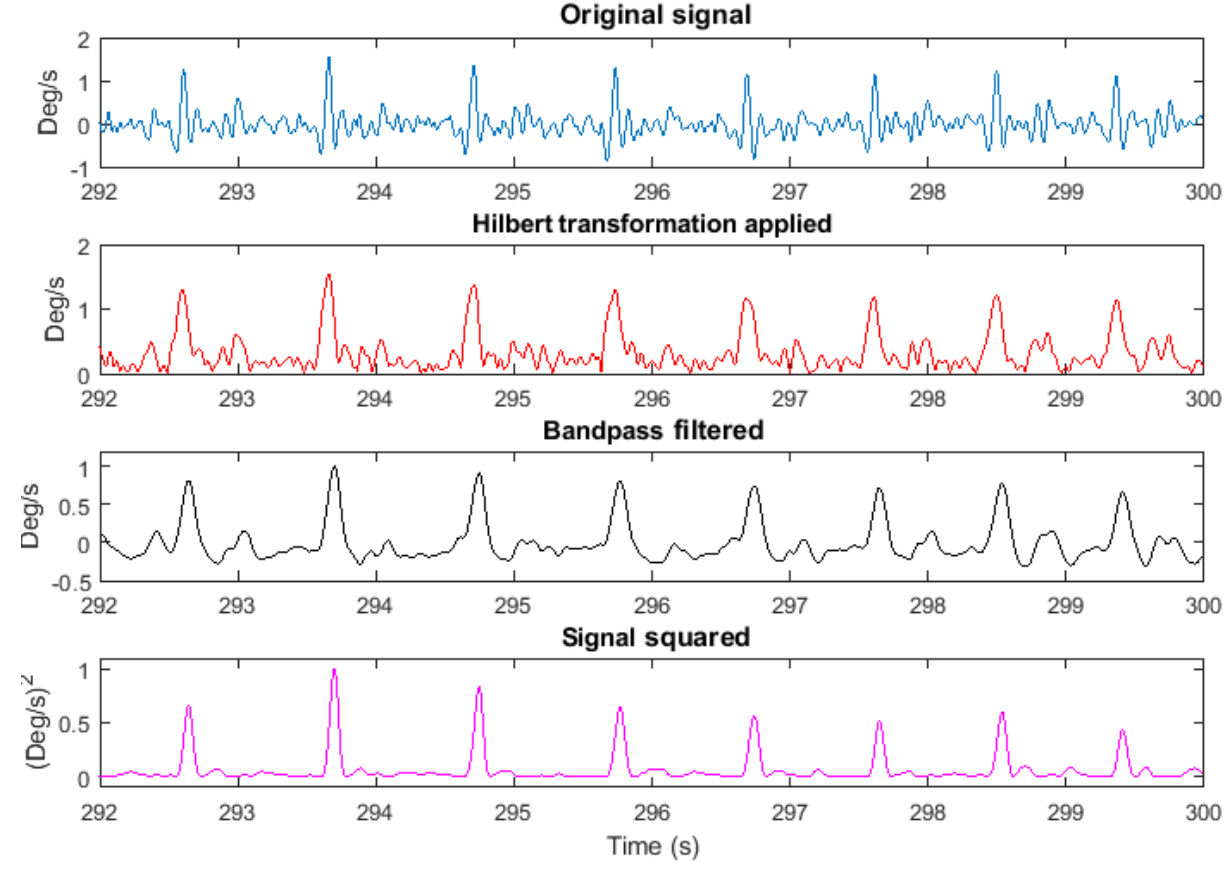
Figure 4. An example of how the raw gyroscope signal is transformed to a signal where peak detection can be easily applied. First, the raw signal (top) has a Hilbert transformation applied (second from top). This signal then has a bandpass filter applied (third from top). The signal is finally squared (bottom).